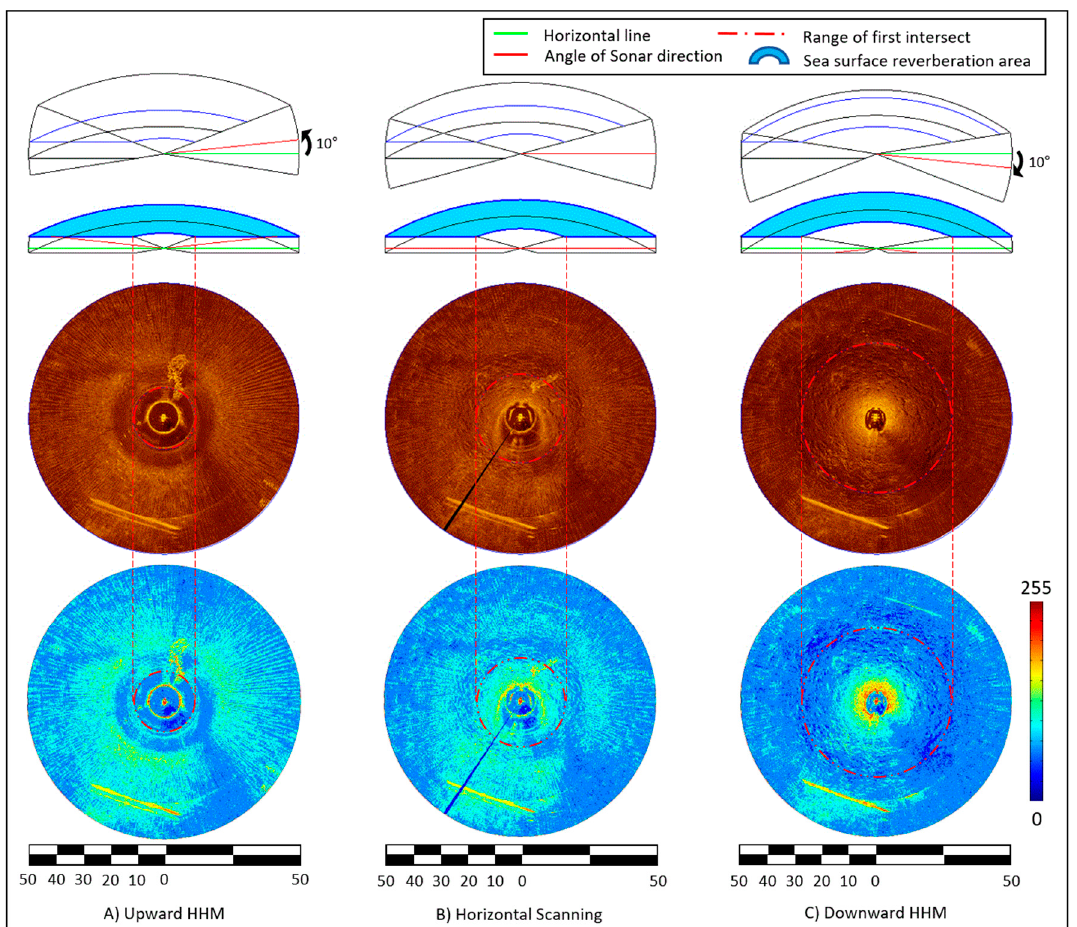
Figure 24. Comparison of scanning images and diagrams of surface reverberation zones according to each HHM [32].